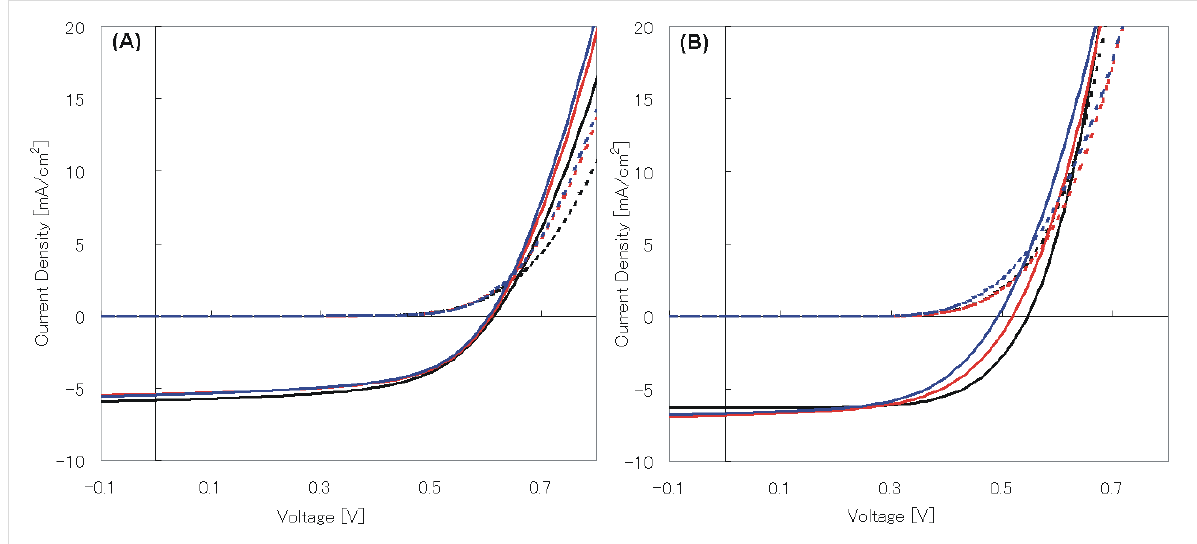
Figure 3: (A) J – V characteristics of the P3HT: 1a -blended device annealed at 100–140 °C (black: 100 °C, red: 130 °C, blue: 140 °C, solid line: current under light, dashed line: current under dark). (B) J – V characteristics of the P3HT:PCBM-blended device annealed at 100–140 °C (black: 100 °C, red: 130 °C, blue: 140 °C, solid line: with light current, dashed line: with dark current).